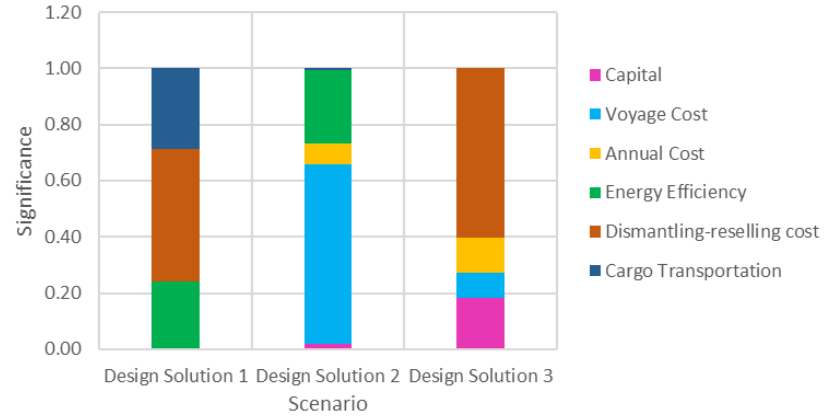
Figure 2. Significance of design criteria for different design solutions.